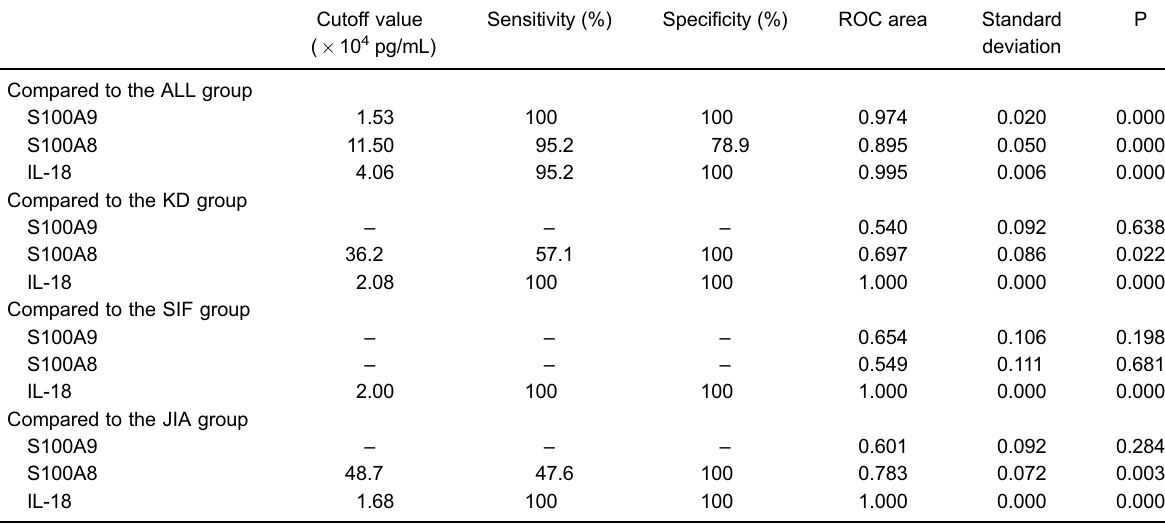
ROC curve: receiver operating characteristic curve. The maximum values of speci fi city and sensitivity are the cutoff values of the markers for differentiating sJIA from ALL, KD, JIA, and SIF patients. ALL: acute lymphoblastic leukemia; SIF: severe infections; KD: Kawasaki disease; JIA: juvenile idiopathic arthritis; sJIA: systemic-onset JIA. Statistical analysis was performed with Dunnett ’ s T3 test and H test.